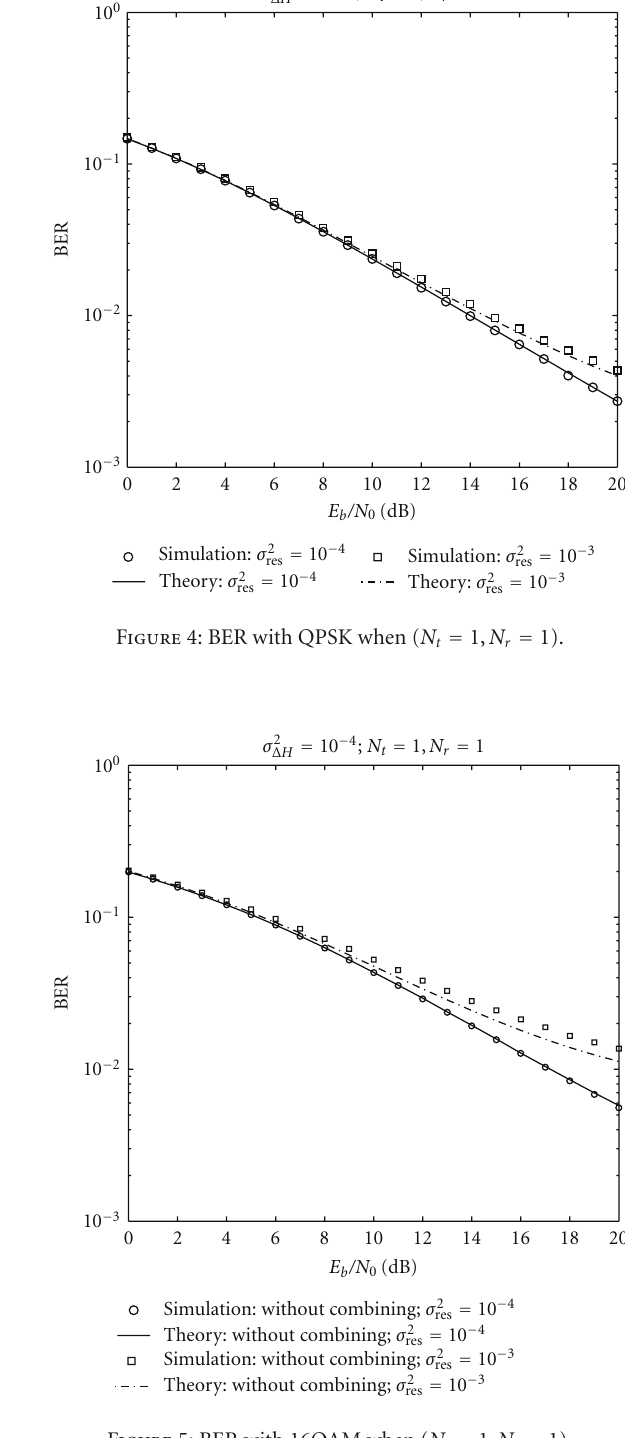
Figure 5: BER with 16QAM when ( N t = 1, N r =